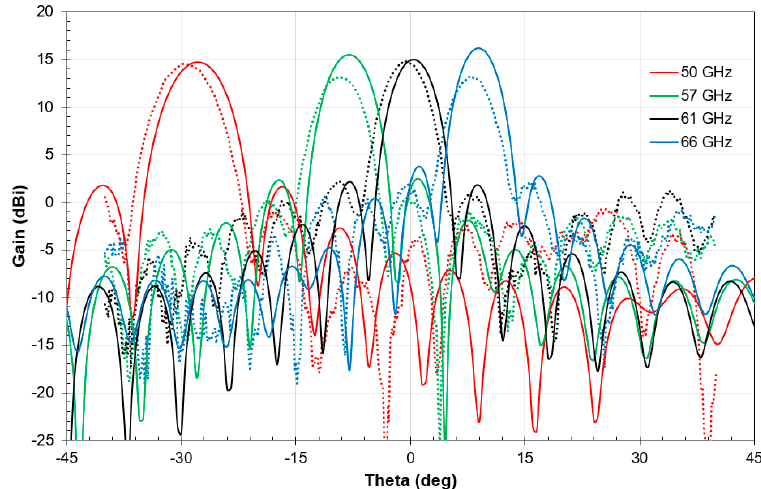
Figure 7. H-plane radiation patterns as the measured (dots) and simulated (solid lines) gain of the SIW LWA over the beam angle theta in degrees at frequencies of 50 GHz (red), 57 GHz (green), 61 GHz (black), and 66 GHz (blue).